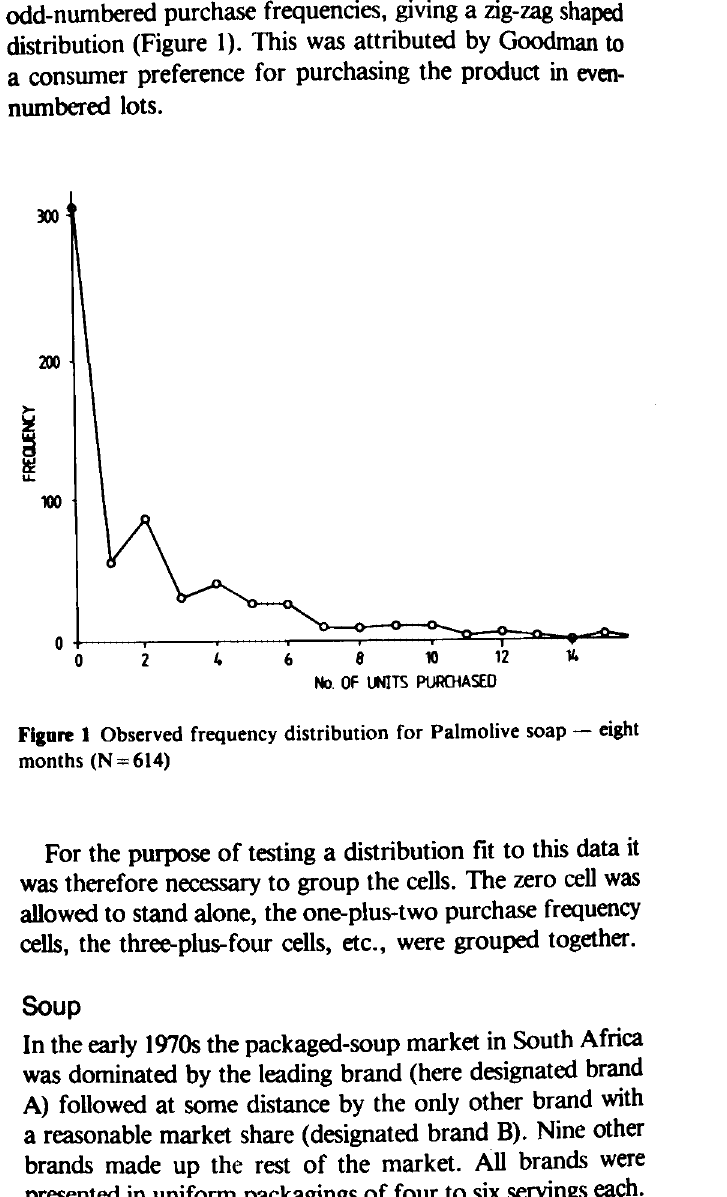
Figure 1 Observed frequency distribution for Palmolive soap - eight months (N =